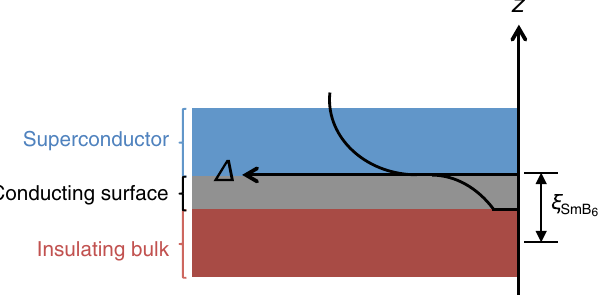
FIG. 3. Model for the proximity effect for superconducting-TI system. Given the surface conducting channel of the SmB 6 as discussed in the text, we adopt the model of the proximity effect for the superconducting layer and the surface conduction channel, the surface state of SmB 6 . The plot in the schematic represents the evolution of the superconducting pair potential [ Δ ð z Þ ]. In this model, we consider the case where the normal coherence length of SmB 6 ( ξ ) is larger than the thickness of the surface state of SmB 6 SmB 6 ( t surface